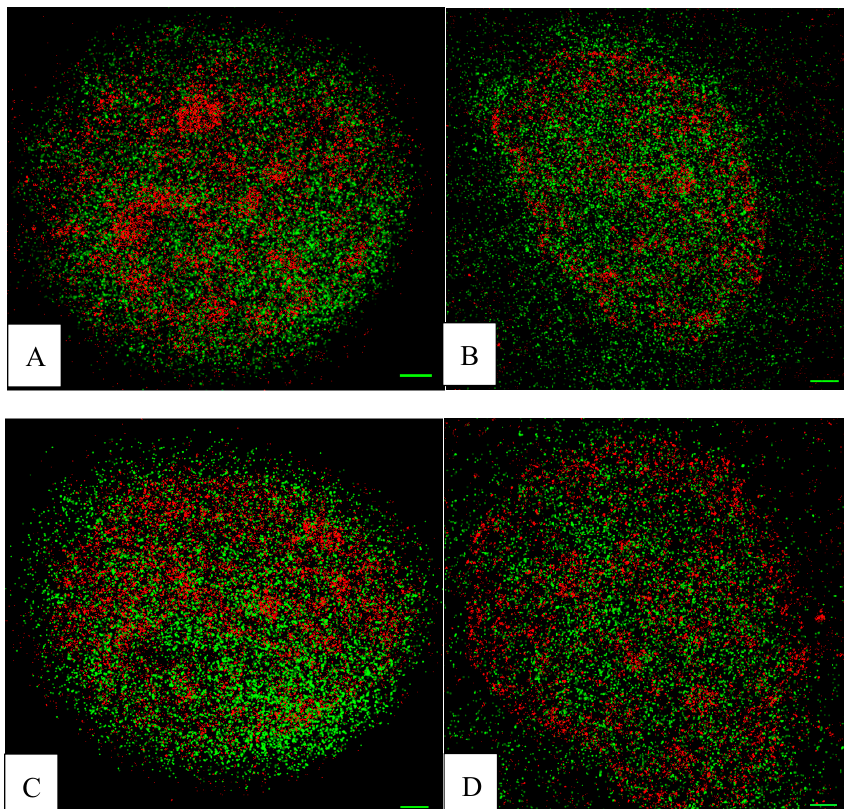
Figure 2. Examples of pointillist image sections obtained by reconstruction from the “orte-matrix” of the cell nuclei. Two colour planes are merged. Each point represents the position of a fluorescent tag (red: H3K9me3; green: γ -H2AX). Further counterstaining was omitted. ( A ) FC after 13 weeks cultivation; typically heterochromatin shows high and less-condensed regions, and γ -H2AX is dispersed over the whole nucleus; ( B ) FD (=13 weeks folate depletion); the γ -H2AX distribution seems to be dispersed without cluster formation, whereas the heterochromatin appears to be less condensed; ( C ) FR5 (=5 weeks folate repletion); there seems to appear a recovery of dense heterochromatin regions with γ -H2AX dispersed but also clustered; ( D ) FR15 (=13 weeks folate depletion and 15 weeks folate repletion); the heterochromatin seems to be clustered, but the number of γ -H2AX signals seems to be reduced. For further details see quantitative results; scale-bar = 1 µm.